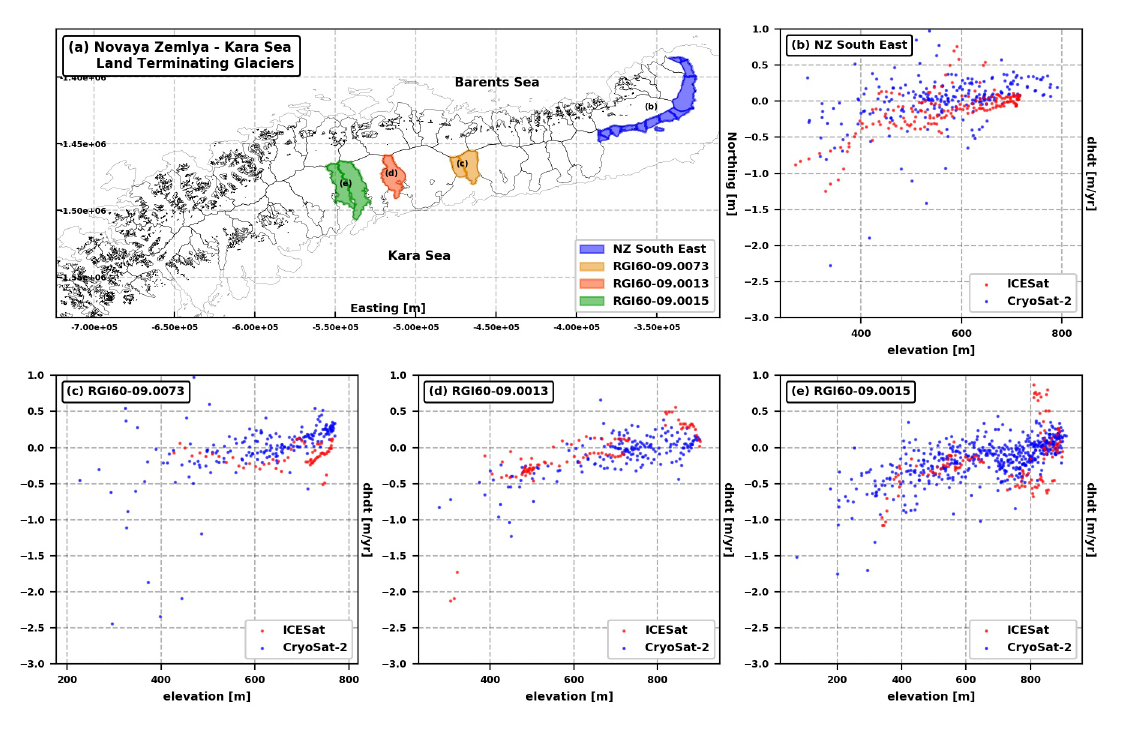
Figure 6. Elevation vs. elevation changes calculated for the major land-terminating glaciers facing the Kara Sea using ICESat and CryoSat-2. ( a ) Novaya Zemlya Glaciers, ( b ) NZ South East